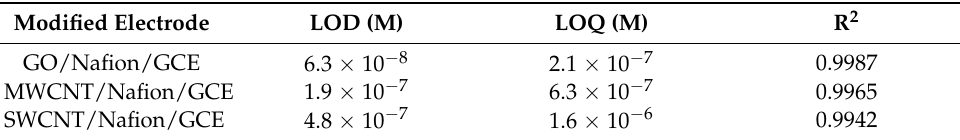
Table 3. Calibration parameters obtained for MG determination by different carbonaceous materials used in the modification of the GCE. See the abbreviation list at the end of the article. Modified